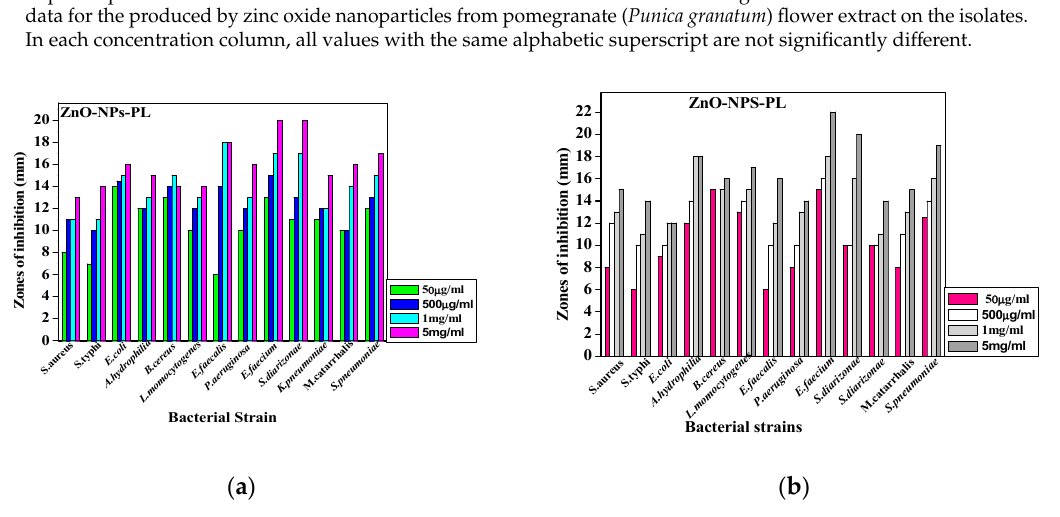
Figure 12. ( a ) Bar graphs showing the e ff ect of di ff erent concentrations (50 µ g / mL, 500 µ g / mL, 1 mg / mL and 5 mg / mL) on antimicrobial activity of ZnO-NPs-PL against various microorganisms. ( b ) Bar graphs showing the e ff ect of di ff erent concentrations (50 µ g / mL, 500 µ g / mL, 1 mg / mL and 5 mg / mL) on antimicrobial activity of ZnO-NPs-PF against various microorganisms. Table 4. Mean zones of inhibition value (mm) produced by zinc oxide nanoparticles mediated via pomegranate ( Punica granatum ) flower extract.